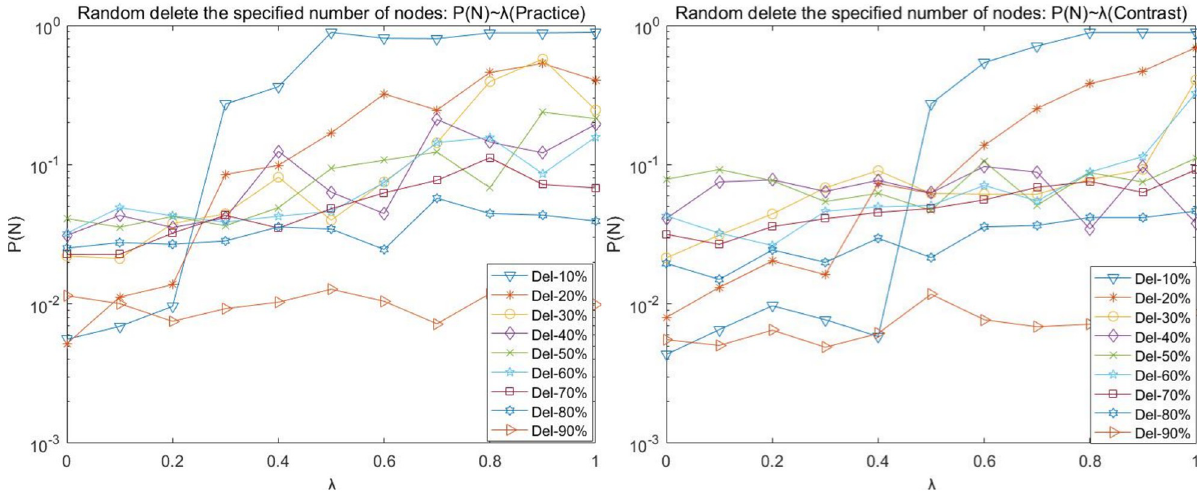
Fig 2. Random disruption- P ( N ) with λ variation diagram.